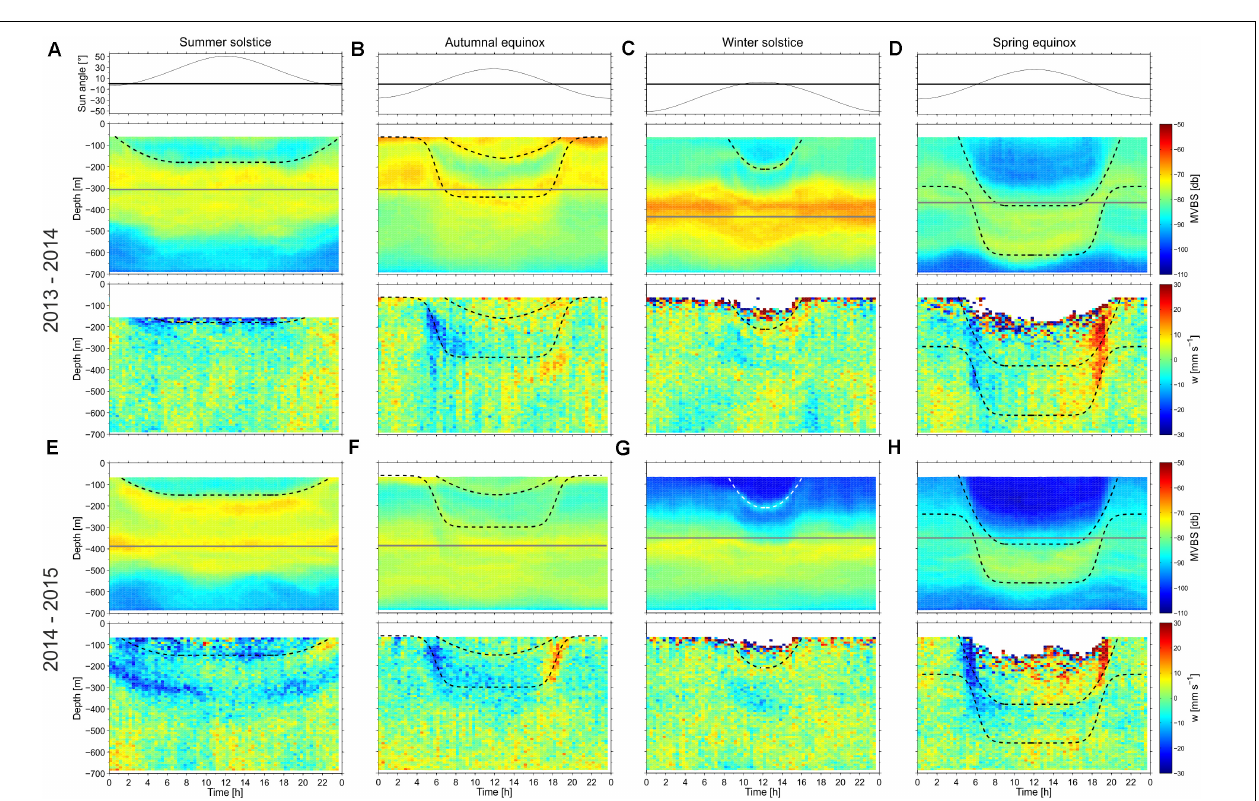
FIGURE 6 | Mean diel cycle of the sun angle (upper panels), mean volume backscattering strength MVBS (mid-panels) and Doppler vertical velocity w (lower panels) estimated for four different weeks near (A,E) summer solstice, (B,F) autumnal equinox, (C,G) winter solstice and (D,H) spring equinox of the years 2013–2015. The average interface depth over each individual week (see Figure 3 ) is illustrated with a horizontal gray line, and the discussed backscatter layers are emphasized with dashed curves.